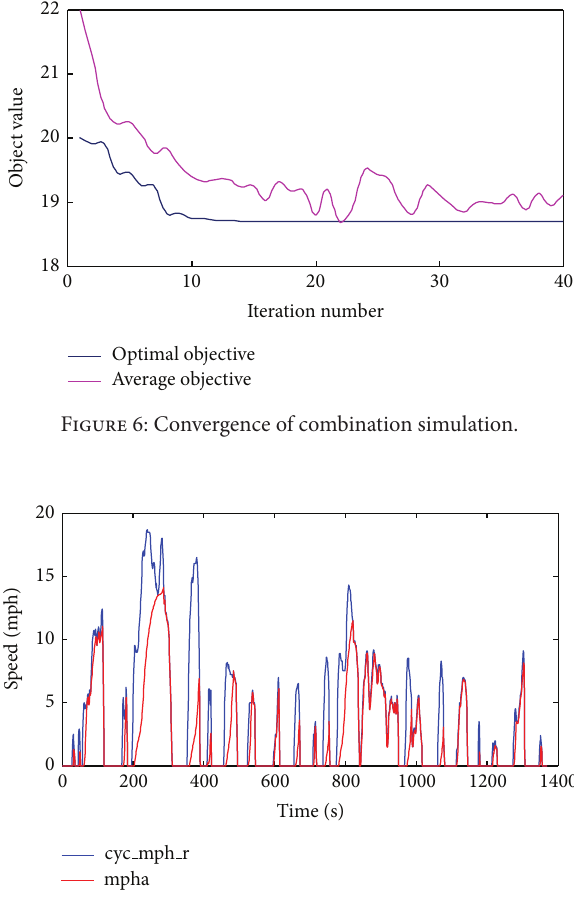
Figure 7: 𝜆 1 = 0.4 , 𝜆 2 = 0.6 , the speed of simulation & drive